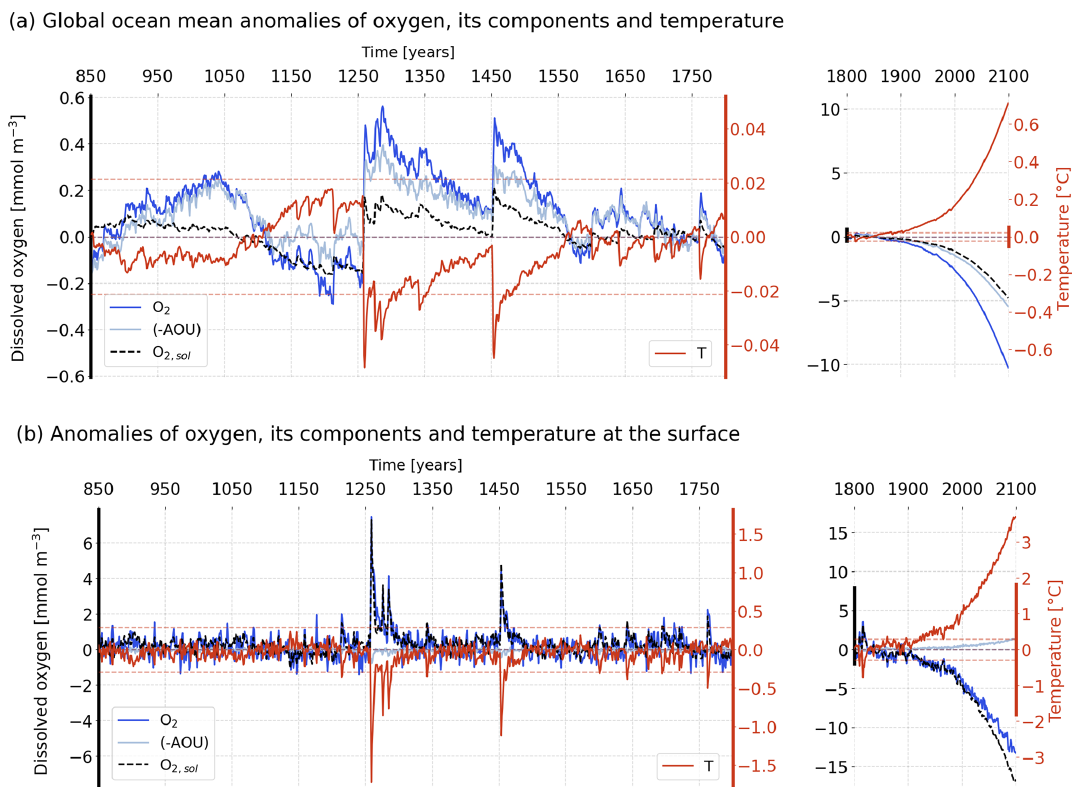
Figure A5. Temporal evolution of simulated anomalies in (a) global mean O 2 (dark blue), − AOU (light blue), the O 2 solubility component (dashed black) and T (red) over the last millennium (left) and the historical and future periods (right). The horizontal dashed lines stand for the 2 standard deviation envelopes for O 2 (blue) and T (red) computed over the period 850–1800CE. (b) Same as (a) but for the surface. The anomalies are relative to the pre-industrial reference period